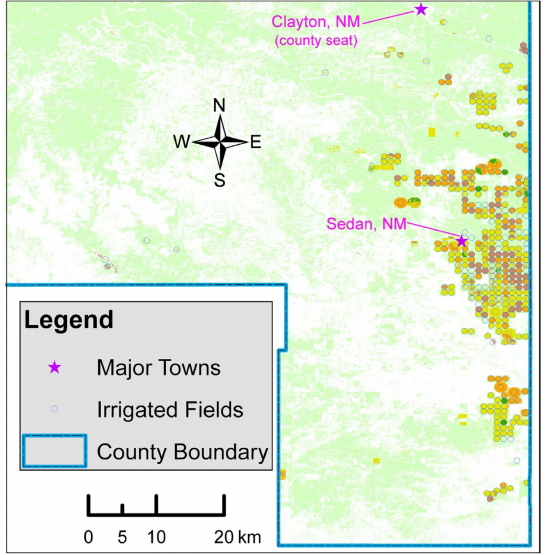
Figure A2. Identified circular irrigated crop field boundaries overlapped with Crop Data Layer data in the central–eastern and southeastern parts of Union County, New Mexico. Note: light green in the background indicates grassland and other colors indicate different crop covers. Data source: NASS, USDA; Google Maps.